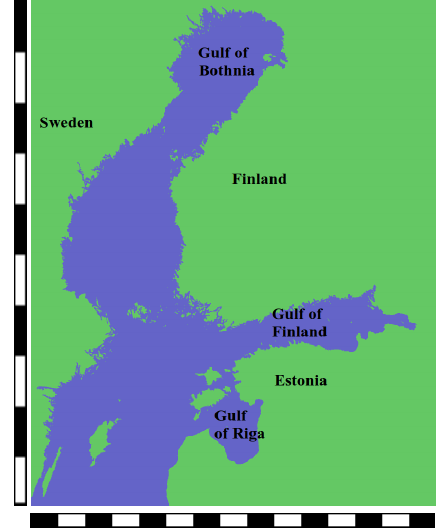
Fig. 1. The Baltic Sea study area. In the image scales the interval is one degree in both latitude and Figure 1. The Baltic Sea study area. In the image scales the interval longitude, the upper left corner is (66 o N,16 o E) and lower right corner (56 o N,31 o E). is 1 ◦ in both latitude and longitude; the upper left corner is located at figure 66 ◦ N, 16 ◦ E, and the lower right corner is located at 56 ◦ N, 31 ◦ E. 27 kilometres) remain stable and typically have a high concen- tration throughout the winter. Winter 2013–2014 was a mild ice winter in the Baltic, and the air temperature also varied from cold to warm (above zero) many times during the win-